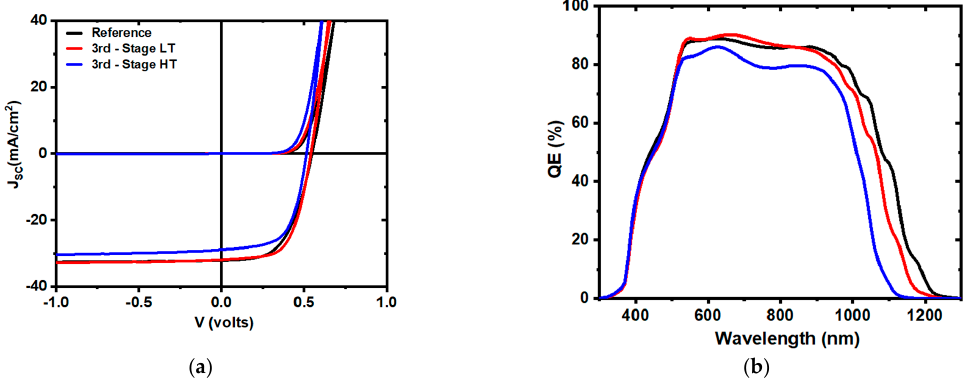
Figure 8. Representative ( a ): J-V curve and ( b ): QE curve for reference (black), third stage LT (red) and third stage HT (blue) devices.